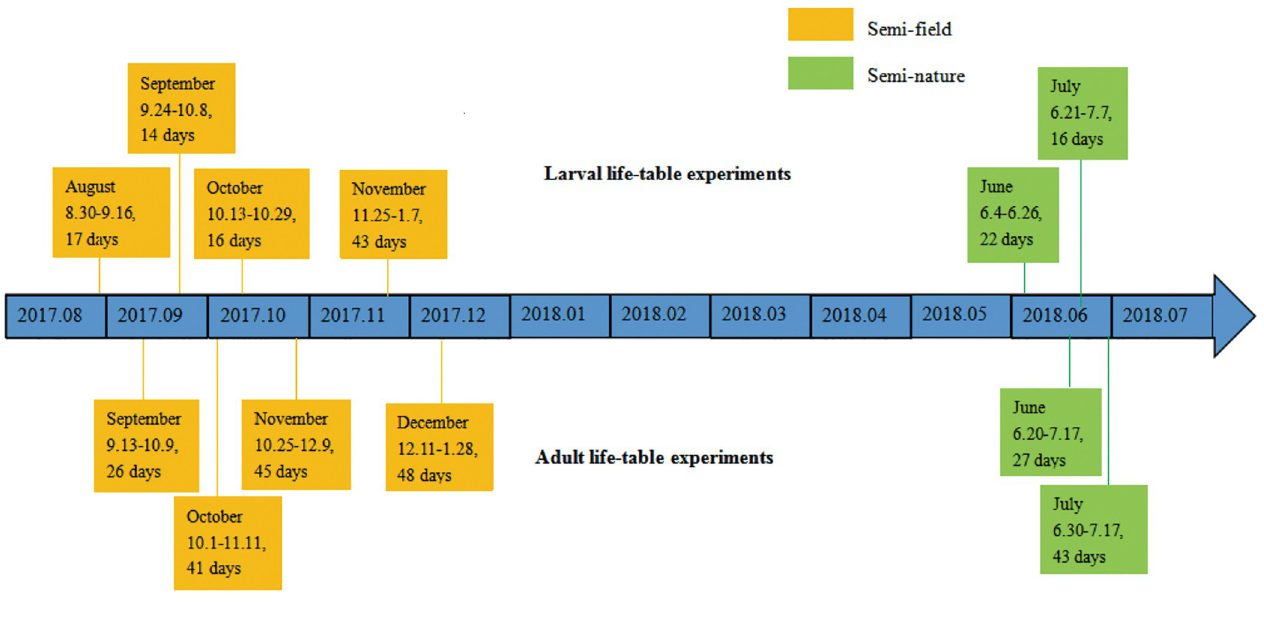
Fig 4. The timeline of the experiments including the starting and ending dates of each experiment. Each text box represented one experiments, which included month, which was used to identify each experiment, the starting/ending dates and the duration (days) of the experiment.